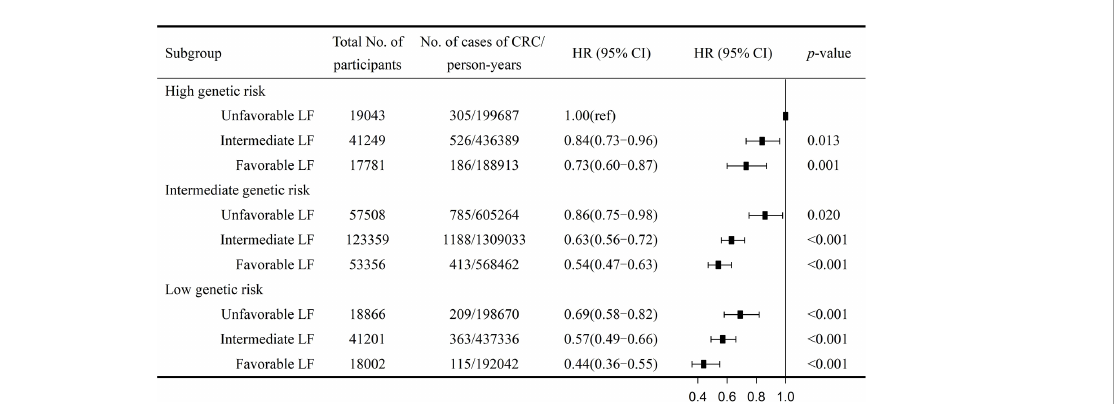
FIGURE 1 Risk of CRC according to genetic and lifestyle risk. LF, lifestyle; HR, hazard ratio; CI, con fi dence interval. Cox proportional hazards regression adjusted for age, sex, education, Townsend deprivation index, and the fi rst 10 principal components of ancestry. p for multiplicative interaction<